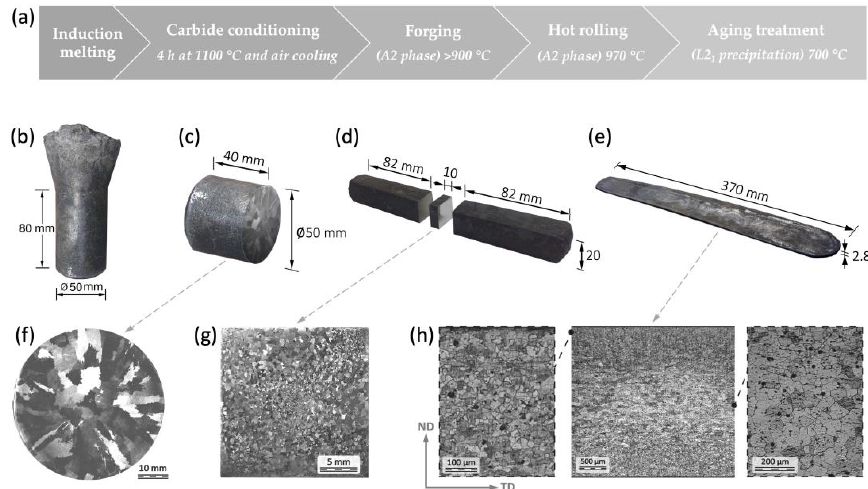
Figure 13. Thermomechanical processing route, samples with dimensions, and grain microstruc- tures throughout the processing. ( a ) Schematic processing route. ( b ) Melted ingot (including riser). ( c ) Section of the ingot for forging. ( d ) Forged bar with cuts for rolling and microstructural observa- tions. ( e ) Hot rolled bar. ( f ) Cross-sectional macrograph of the cast ingot. ( g ) Cross-sectional micro- graph of the forged bar. ( h ) Cross-sectional micrograph of the hot rolled bar including surface and central zones enlargements.